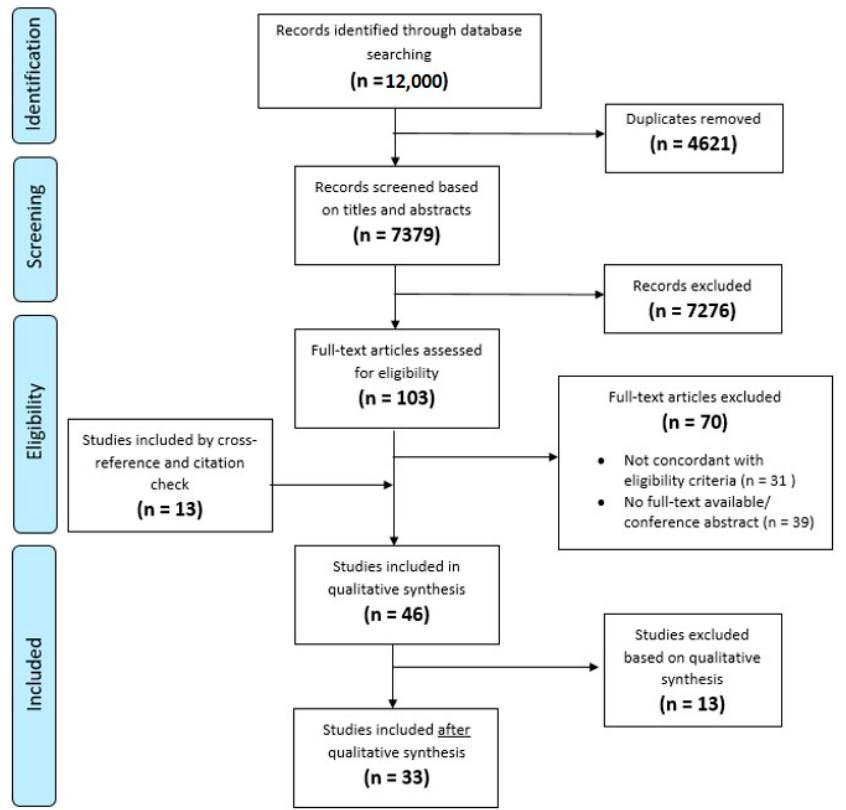
Figure 1. Flowchart inclusion of papers.